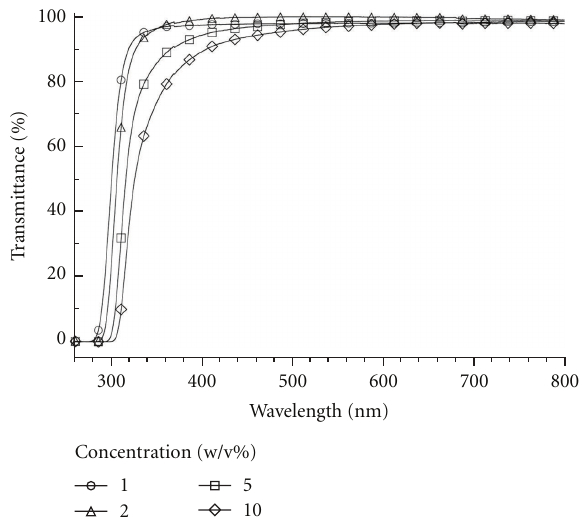
Figure 3: UV-Vis spectra of aqueous dispersions of SQ/ZrO 2 - NPs (feed molar ratio of APTMOS/ZTB = 0.3) with various concentrations.